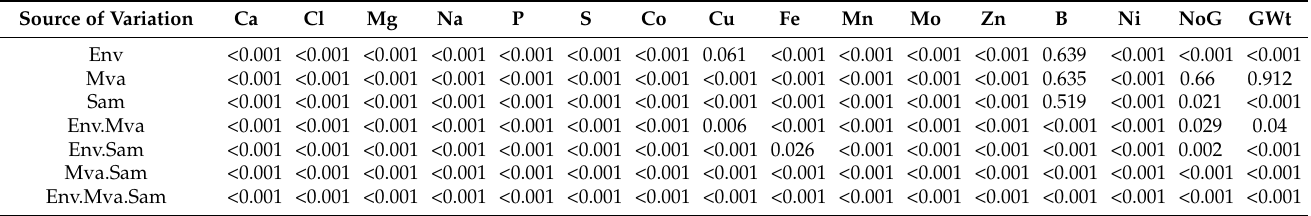
Table 1. The levels of significance for the main and interaction effects of heat stress, maize variety,